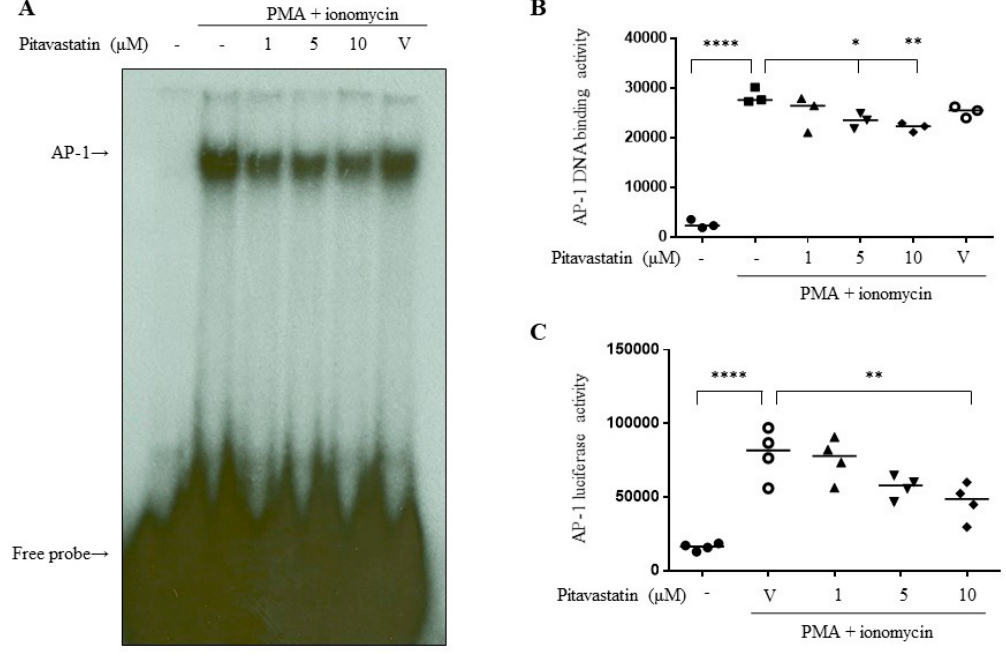
Figure 4. Transcriptional activity of activating protein-1 (AP-1) was blocked by pitavastatin. ( A ) Human primary T cells were pretreated with pitavastatin for 2 h and further stimulated with PMA (5 ng / mL) + ionomycin (1 µ M) for 22 h. Collected nuclear protein extracts were analyzed by electrophoresis mobility shift assay (EMSA). Representative data from three experiments were shown. ( B ) Quantitative results of ( A ) were shown. ( C ) 293T cells were transfected with plasmids encoded by the AP-1 promoter. Transfected cells were pretreated with pitavastatin for 2 h and further stimulated with PMA (5 ng / mL) + ionomycin (1 µ M) for 22 h. Cell lysates were collected for determining luciferase activity. V indicates vehicle control. Data were expressed as the median with individual data of 3-4 independent experiments. Significance were represented as * p < 0.05, ** p < 0.01, and **** p < 0.0001 versus PMA + ionomycin-stimulated group).